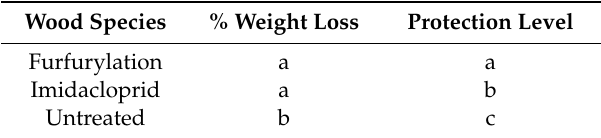
Table 5. Duncan’s multi-range test of percent weight loss and protection level on treatment. (The same letters in each column are not statistically different ( p ≤ 0.05) according to Duncan’s multiple range test.).